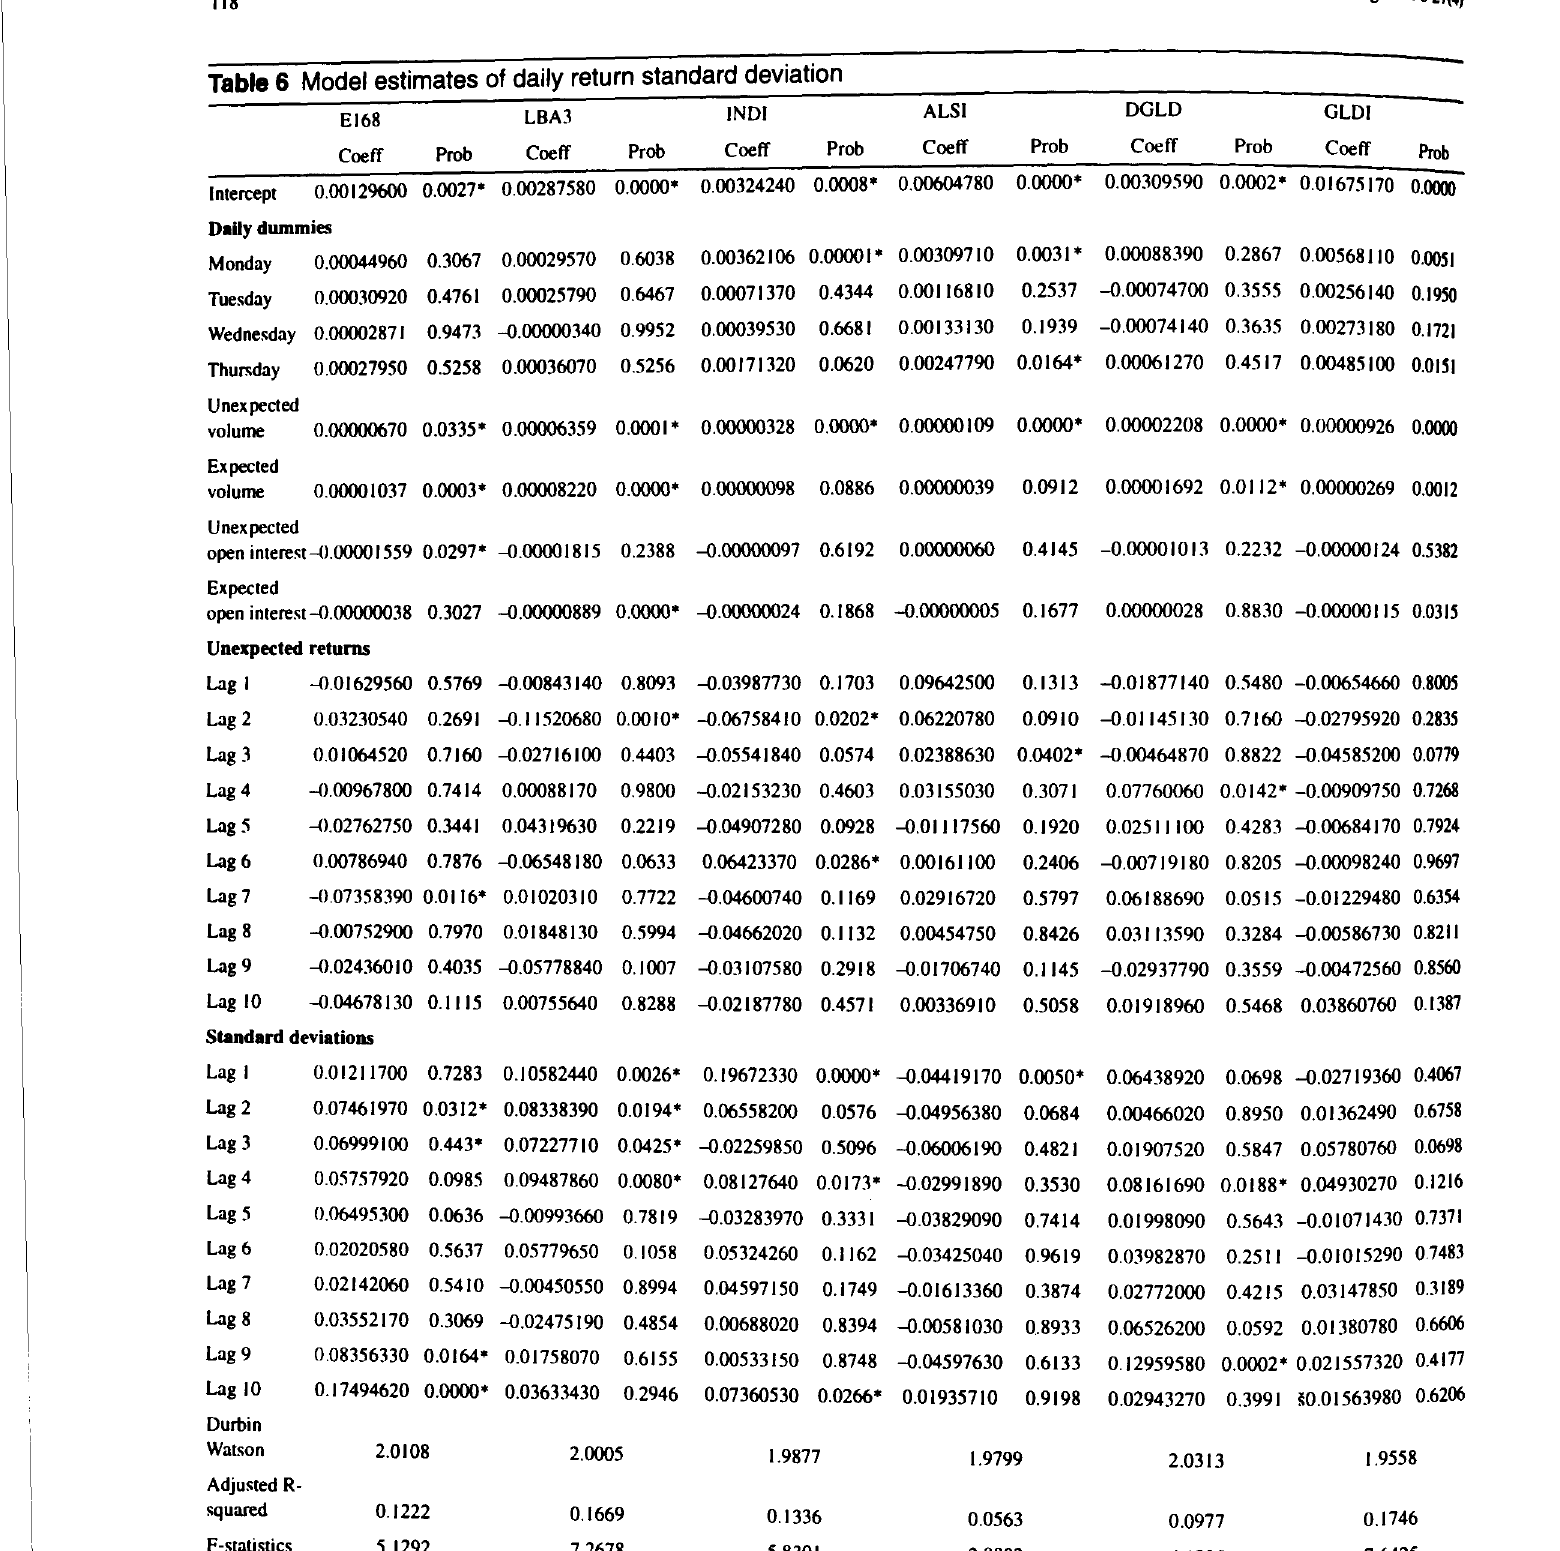
Table 6 Model estimates of daily return standard